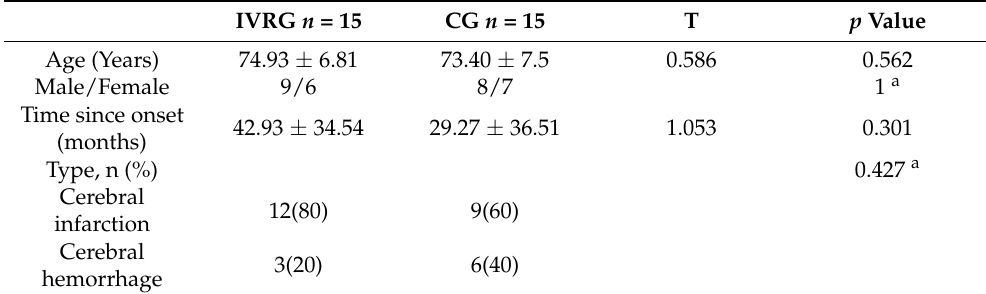
Table 1. Baseline clinical data of elderly stroke patients between the IVRG and